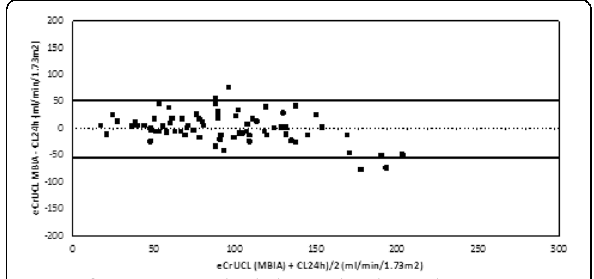
Fig. 2 (abstract 0417). Bland-Altman plot observed vs MBIA- predicted 24h CrUCL (ml/min/1.73